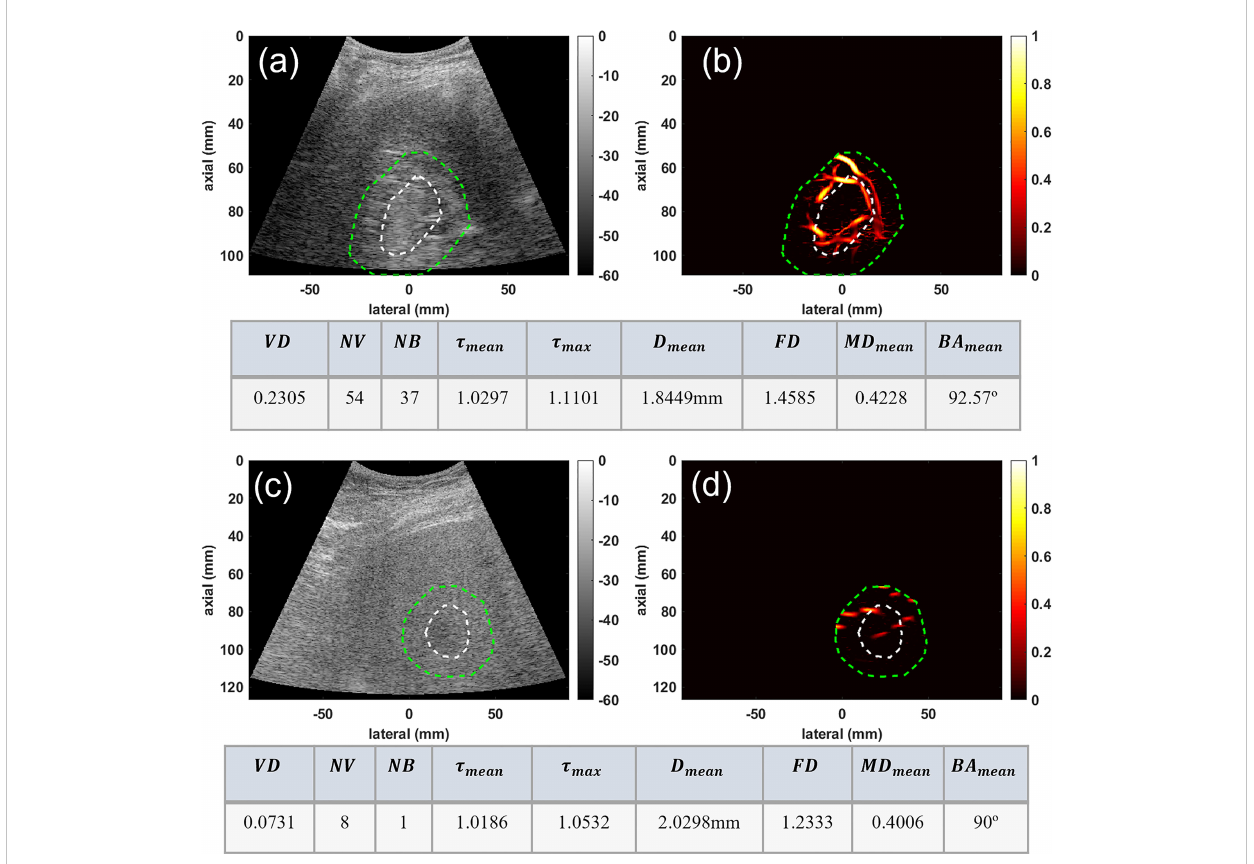
FIGURE 3 Visualization and quanti fi cation of deep-seated HCC and benign masses. (A) B-mode image of a deep-seated HCC tumor (B) Microvasculature image inside the dilated HCC tumor mask (C) B-mode image of a deep-seated benign lesion (D) Microvasculature image inside the dilated benign lesion mask. In all images the white dashed line indicates the boundaries of the lesion, and the green dashed line delineates the boundaries after a 10mm dilation. The tables below each row of images show metric values for the HCC (top) and benign (bottom)